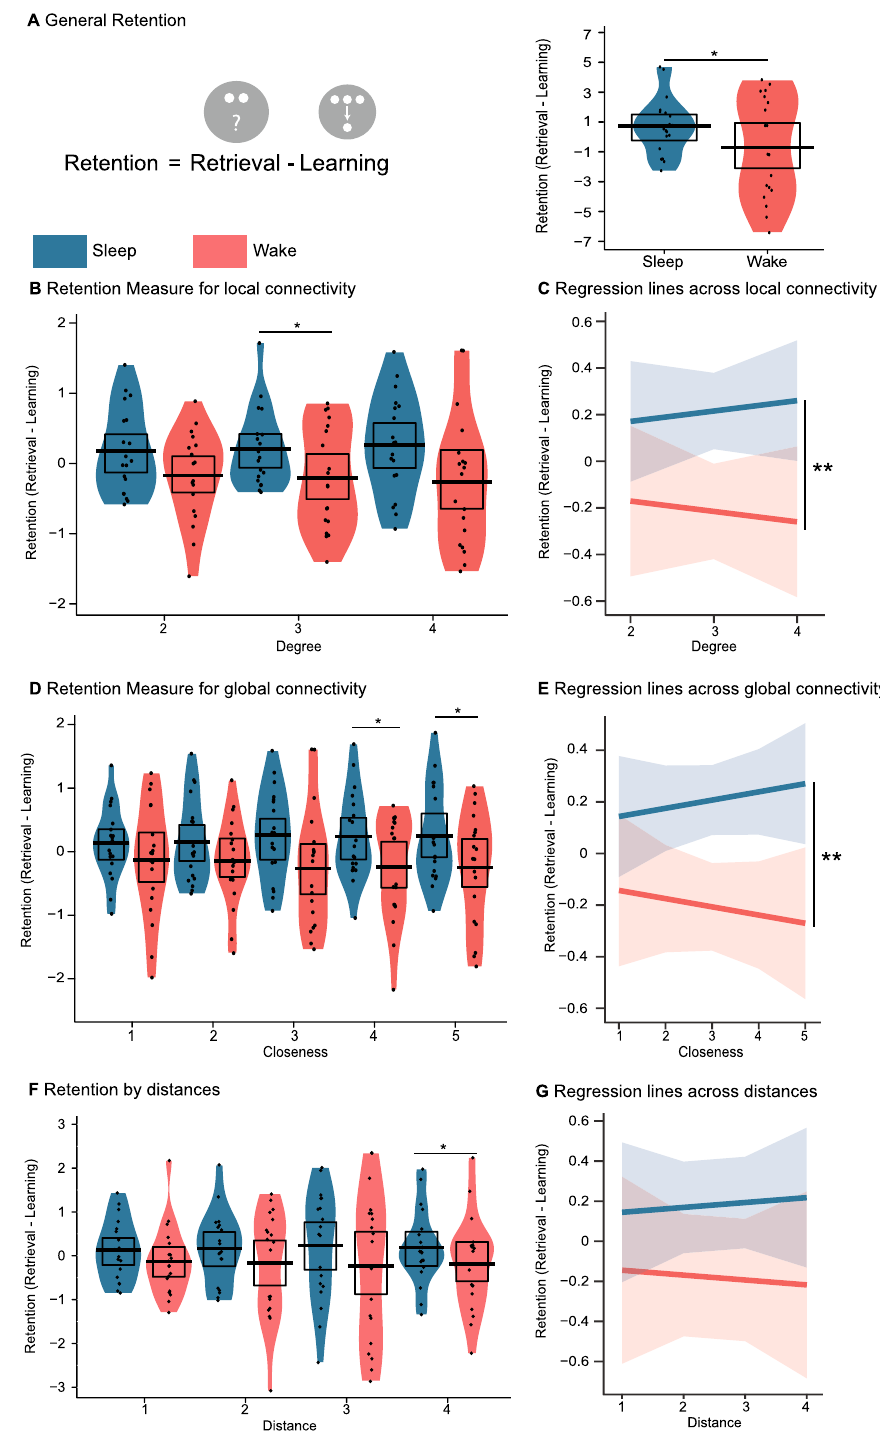
Figure 2. Retention performance. ( A ) Left, the retention measure was calculated by substracting the learning performance from retrieval performance. Details can be found in Supplementary Fig. 4. Right, mean overall retention performance for the sleep (blue) and the wake (red) condition. ( B ) Mean retention performance and ( C ) regression model for the different distances within the graph, ( D ) and ( E ) for the different levels of degree centrality of the nodes and ( F ) and ( G ) for the different levels of closeness centrality of the nodes. For the violin plots, the black dots represent the individual performance, the black bar represents the mean across participants, the black rectangle shows the 95% of a Bayesian highest density interval and the coloured shape displays the smoothed density. *p < 0.05, **p <